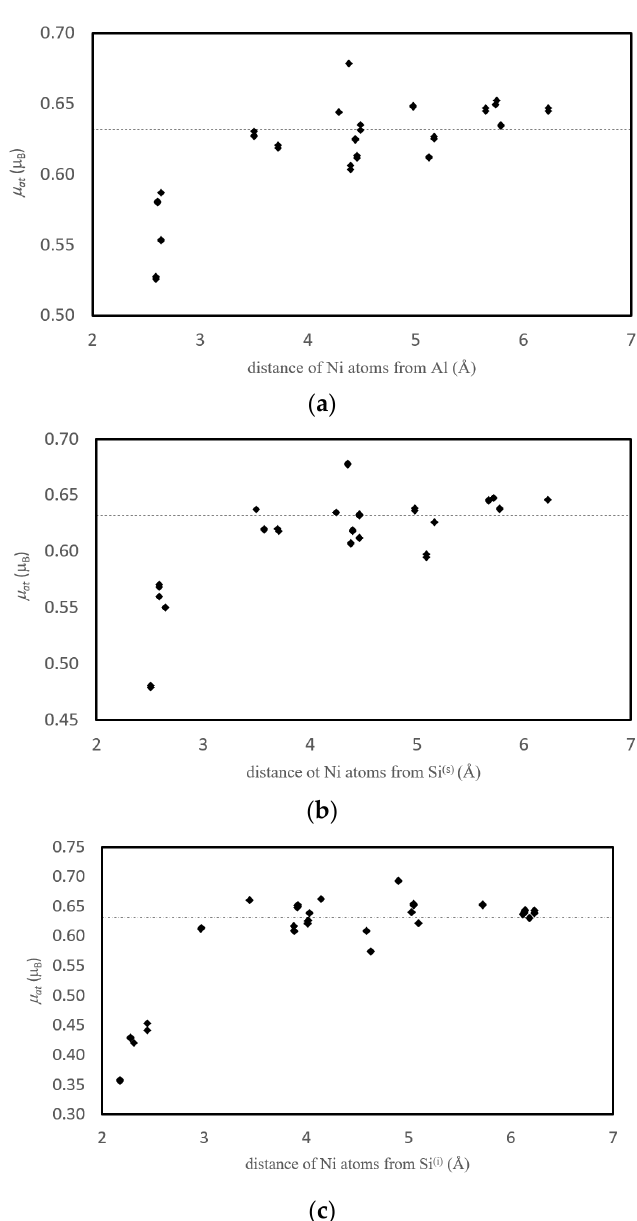
Figure 6. The dependence of magnetic moment of Ni atom on the distance from the impurity: ( a ) GB-Ni 118 Al 2(s) , ( b ) GB-Ni 118 Si 2(s) , ( c ) GB-Ni 120 Si 2(i) . The dashed line corresponds to the magnetic moment of elemental fcc bulk Ni of 0.632 μ B calculated in this work.